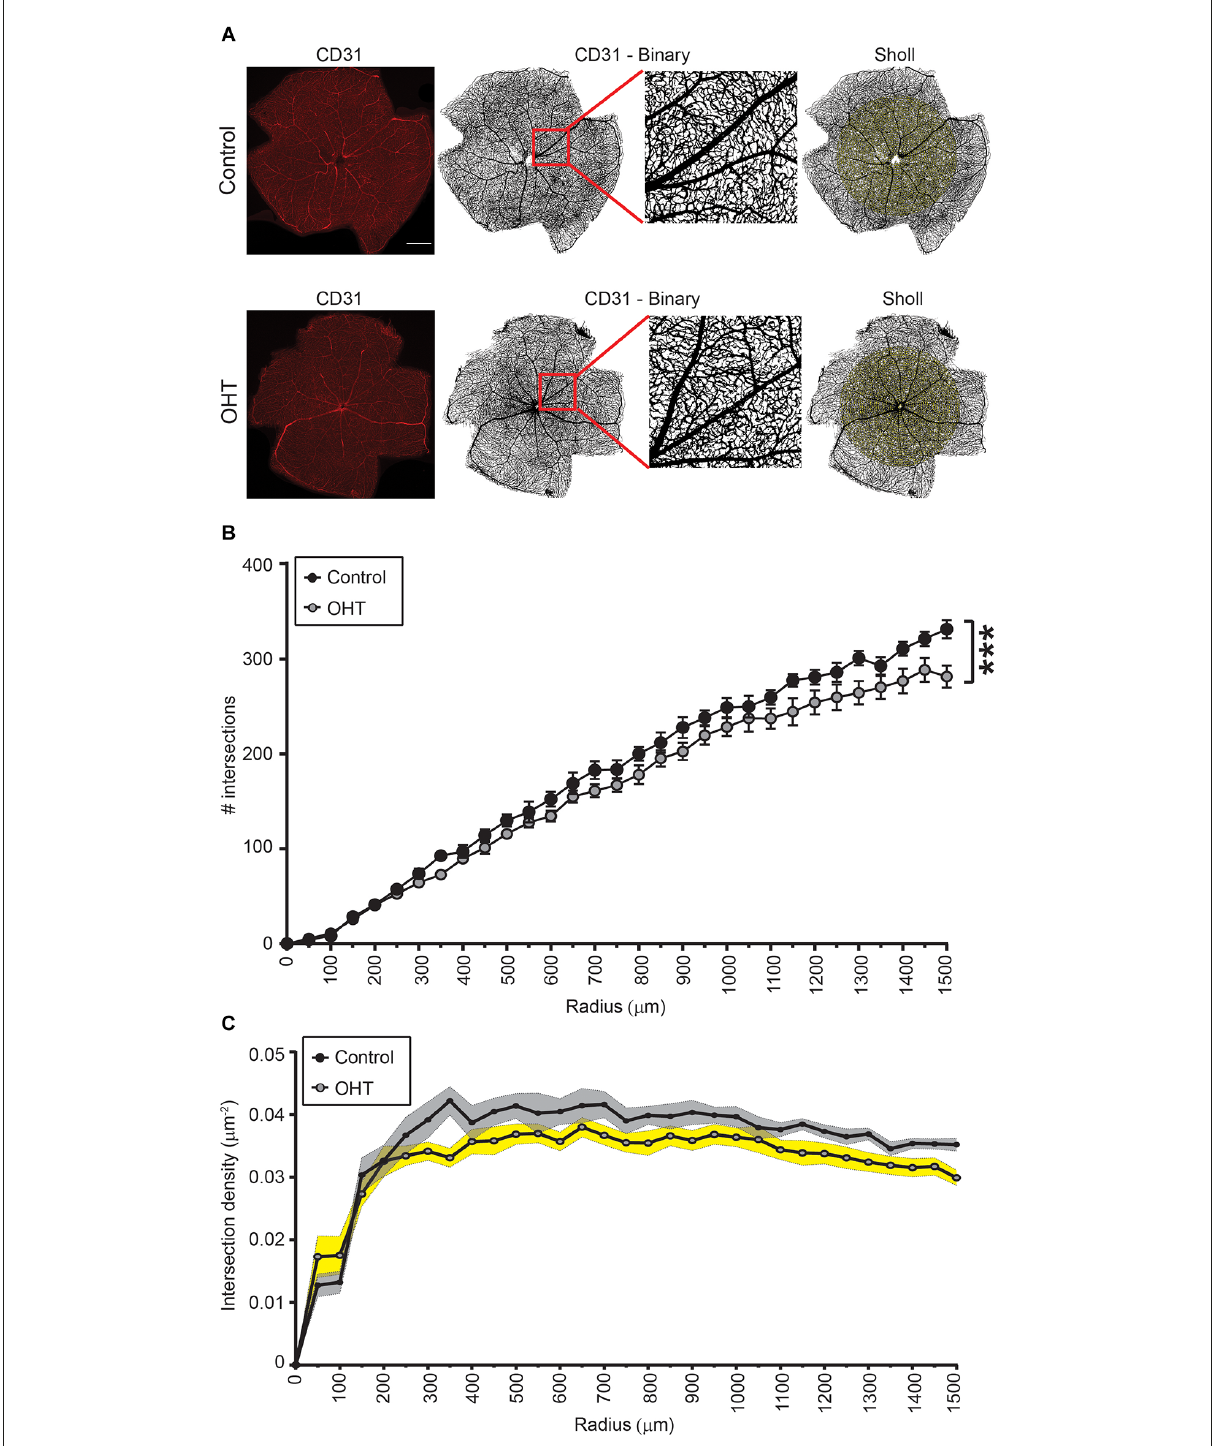
FIGURE2 (A) Representative images of CD31 immunostained retinas for control (top) and OHT (bottom) eyes. Left panels. Original image (scale bar = 500 µ m). Middle two panels. Binary image of the same retinas with inset showing increased magnification. Right panels. Retina showing Sholl analysis patterns (right panels). (B,C) Sholl analysis for radii ranging from 0 to 1,500 µ m. (B) The total number of intersections was significantly reduced in OHT retinas (AUC; *** p < 0.001). (C) Graph showing the total number of intersections as a function of the retinal explant area (intersection density) for both control and OHT